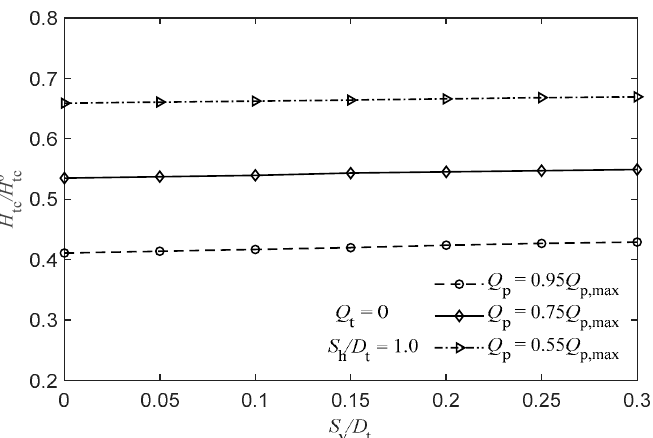
Figure 12. Relative pressure head on the tunnel crown versus the height difference between the parallel adit and tunnel.